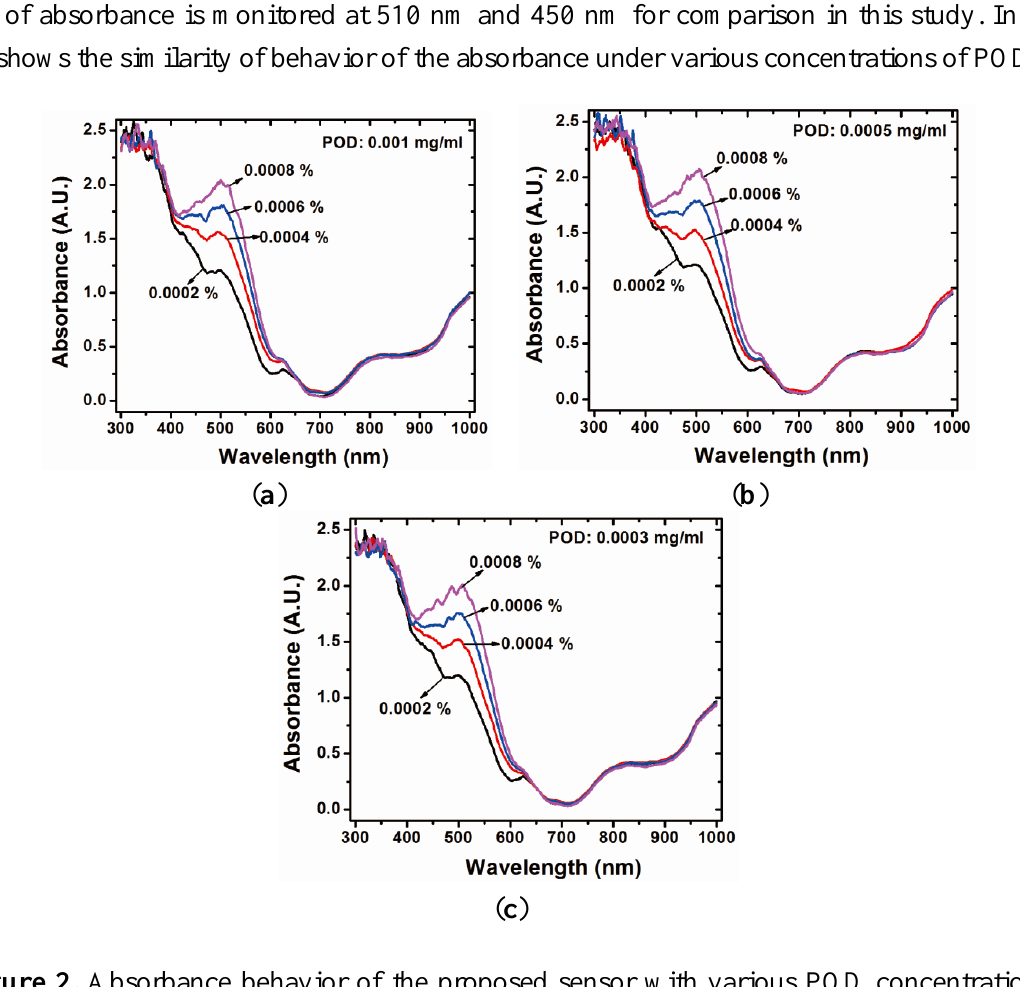
Figure 2. Absorbance behavior of the proposed sensor with various POD concentrations: ( a ) 0.001 mg/mL; ( b ) 0.0005 mg/mL; and ( c ) 0.0003